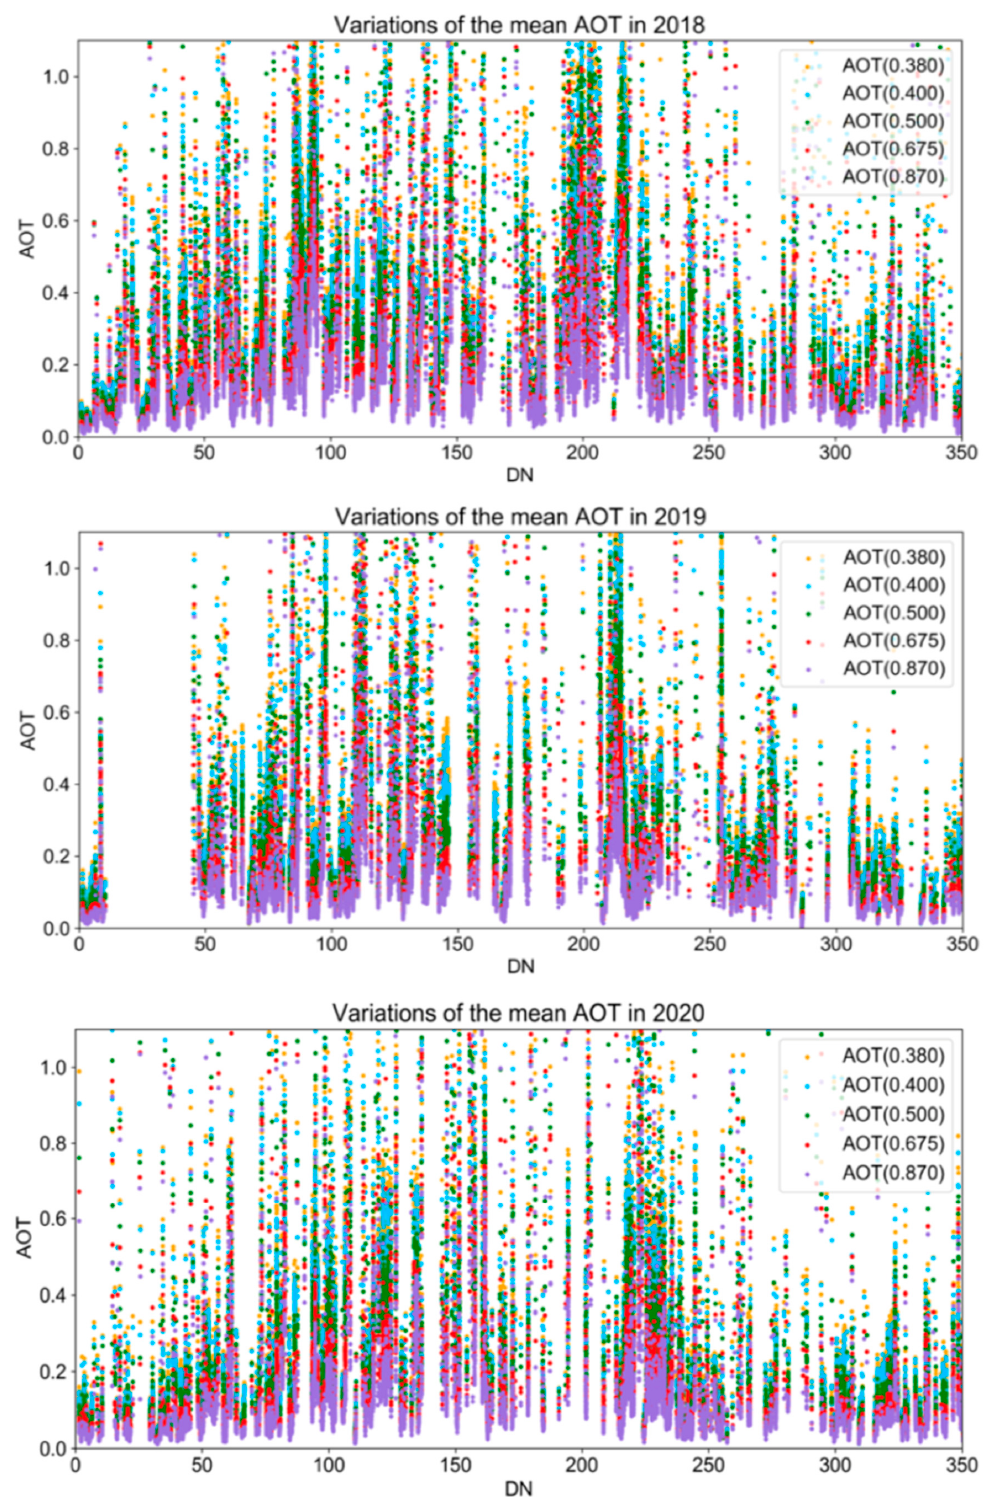
Figure 11. Yearly mean values of AOTs observed with the sky-radiometer from various wavelengths (data are from 2018, 2019, and 2020,